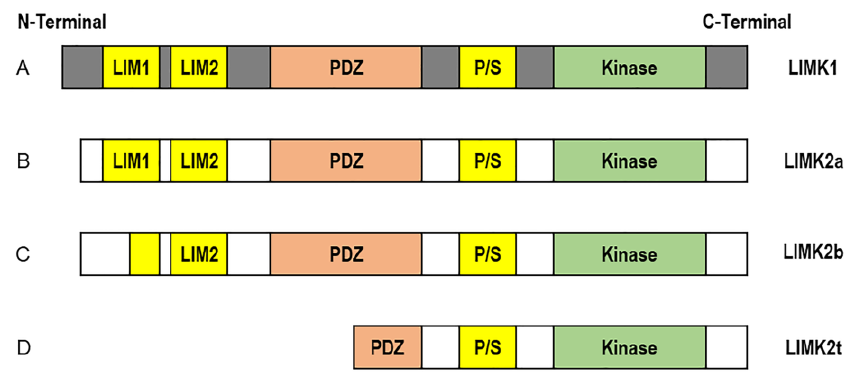
Figure 1. Schematic structure of LIM Kinases. ( A ) The LIMK1 and LIMK2 proteins are composed of an N-terminal kinase domain, two LIM domains, a PDZ domain, proline/serine (P/S)-rich region, and a C-terminal kinase domain. ( B ) LIMK2a, the full-length LIMK2 protein. ( C ) LIMK2b, missing half of the first LIM domain. ( D ) LIMK2t, the testis-specific protein, missing the 2 LIM domains and part of the PDZ domain.